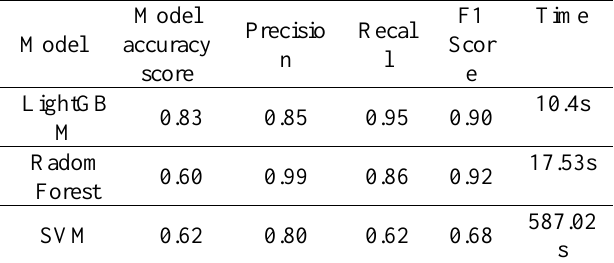
Figure 3. The 3rd decision tree